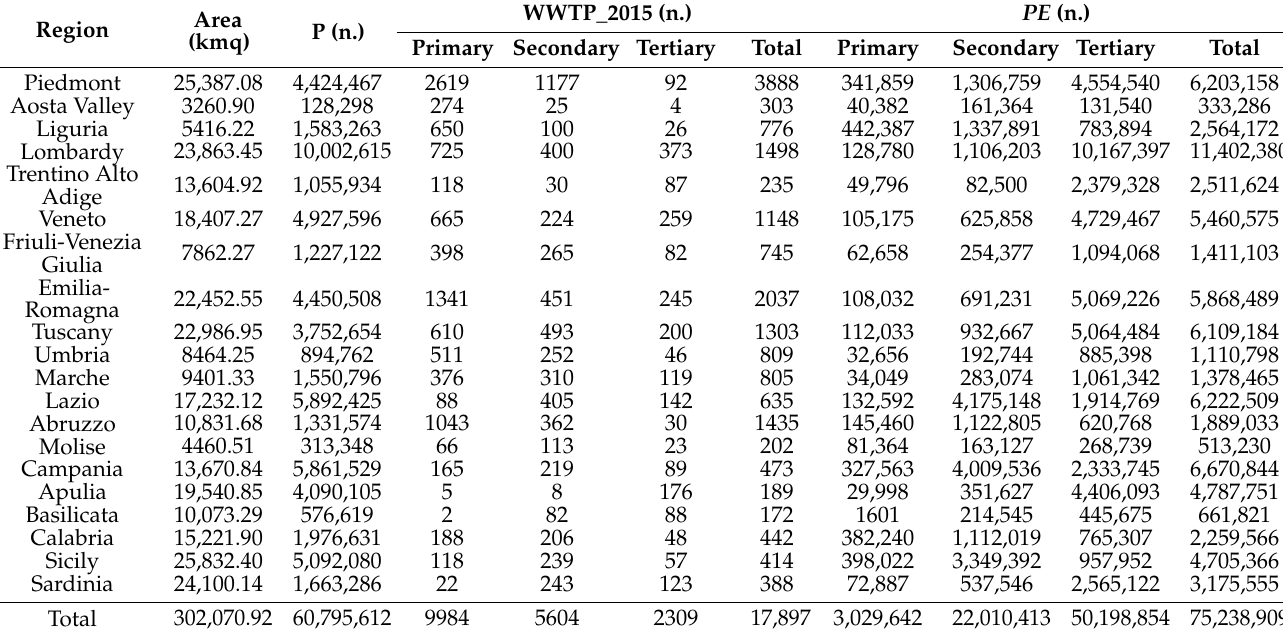
Table 1. Distribution of area, population, number of municipal WWTPs and population equivalents ( PE ) in Italy [45].